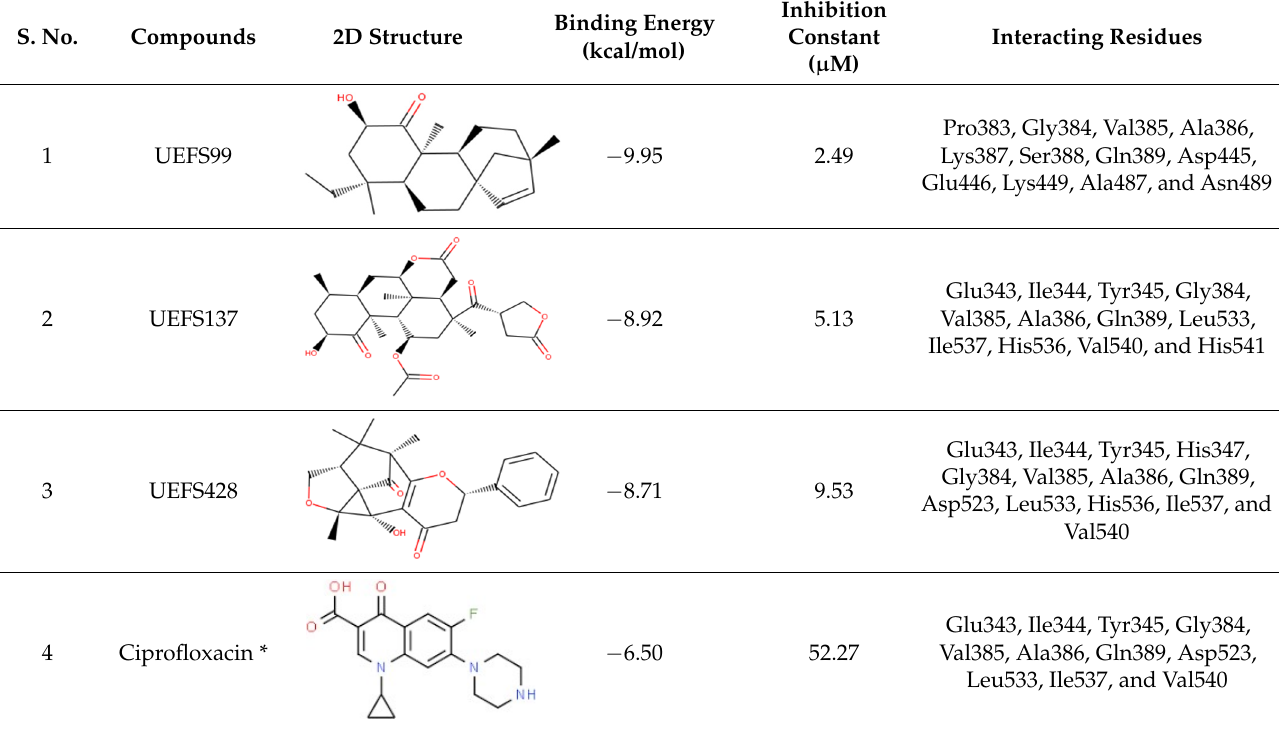
Table 1. BE of hit compounds with MCM7 protein.